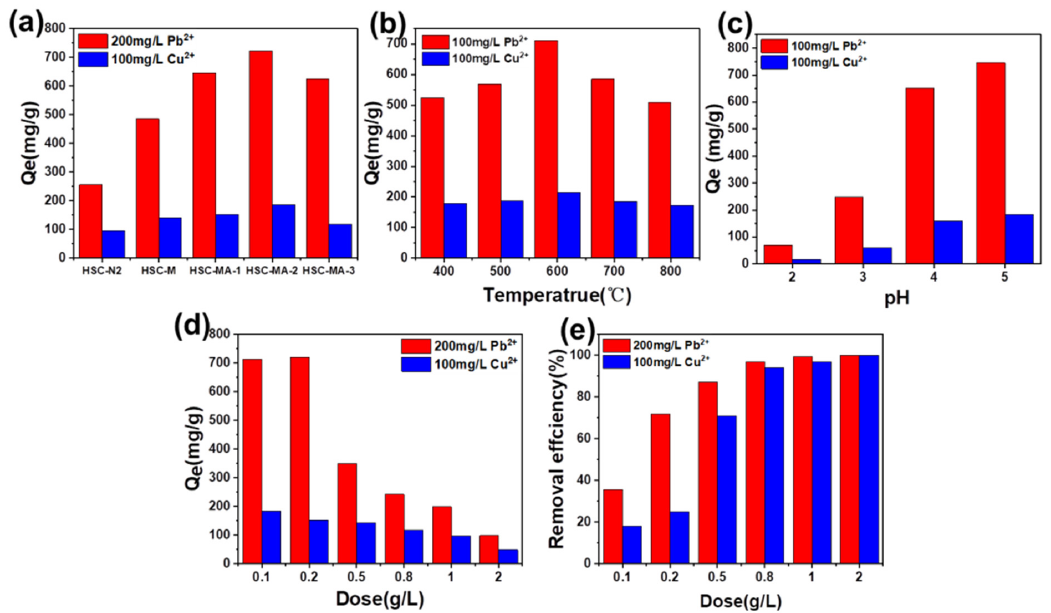
Figure 6. Influence of the modifying agents ( a ), temperatures ( b ), pH ( c ) and the dosage ( d , e ) on the adsorption capacity and removal efficiency of Pb 2+ and Cu 2+